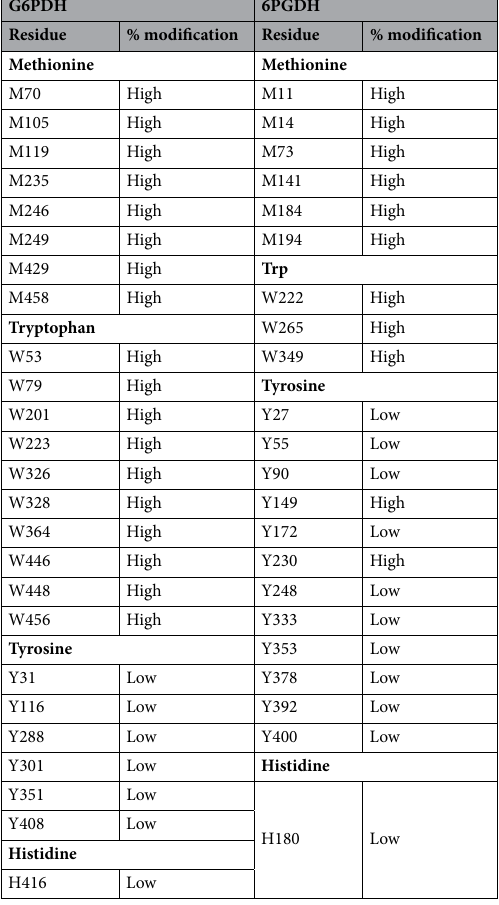
Table 3. Comparison of modified amino acids at specific sites in G6PDH and 6PGDH mediated by AAPH- · derived ROO . High and low refer to the % modification, using 10% as the threshold between high and low values. The numbering of the amino acids is taken from the protein sequences reported in UniProt database entry P0AC53 and P00350 for G6PDH and 6PGDH,